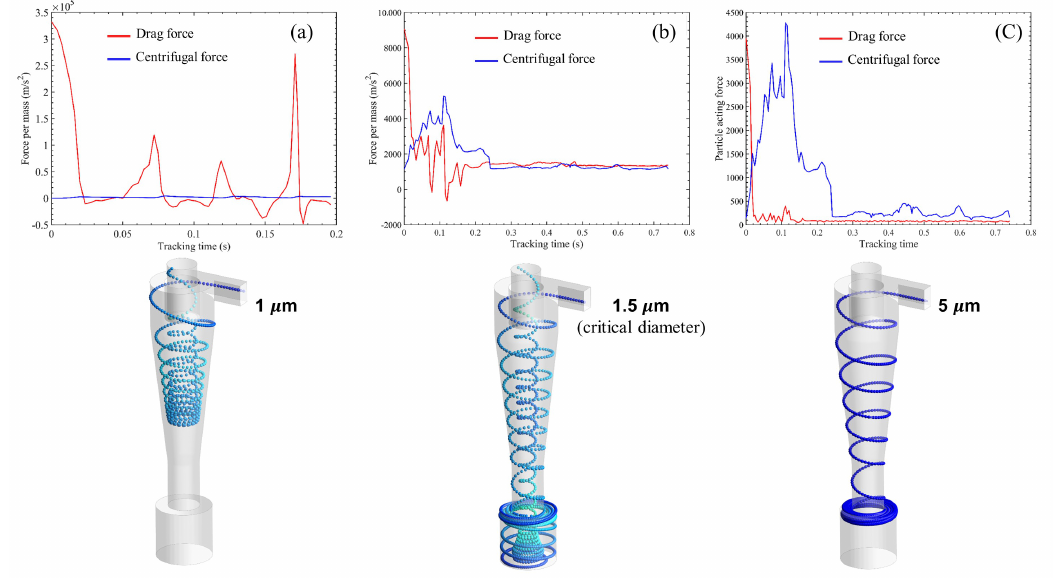
Figure 7. The force analysis acting on particle; ( a ) 1 µ m behavior, ( b ) 1.5 µ m behavior, ( c ) 5 µ m behavior. To quantify this separation phenomenon, the forces acting during the separation time were averaged. The force results compared with the separation e ffi ciency curve as shown in the Figure 8. The di ff erence in the equilibrium action of centrifugal force and drag occurs around the diameter with a separation e ffi ciency of 50%. That is, the diameter with the same centrifugal force and drag force with 50% separation e ffi ciency is the critical diameter that can explain the cyclone particle separation. The critical diameter, in which centrifugal force and drag force act similarly, is an important dependent variable. The critical diameter was selected as a neural network output variable.